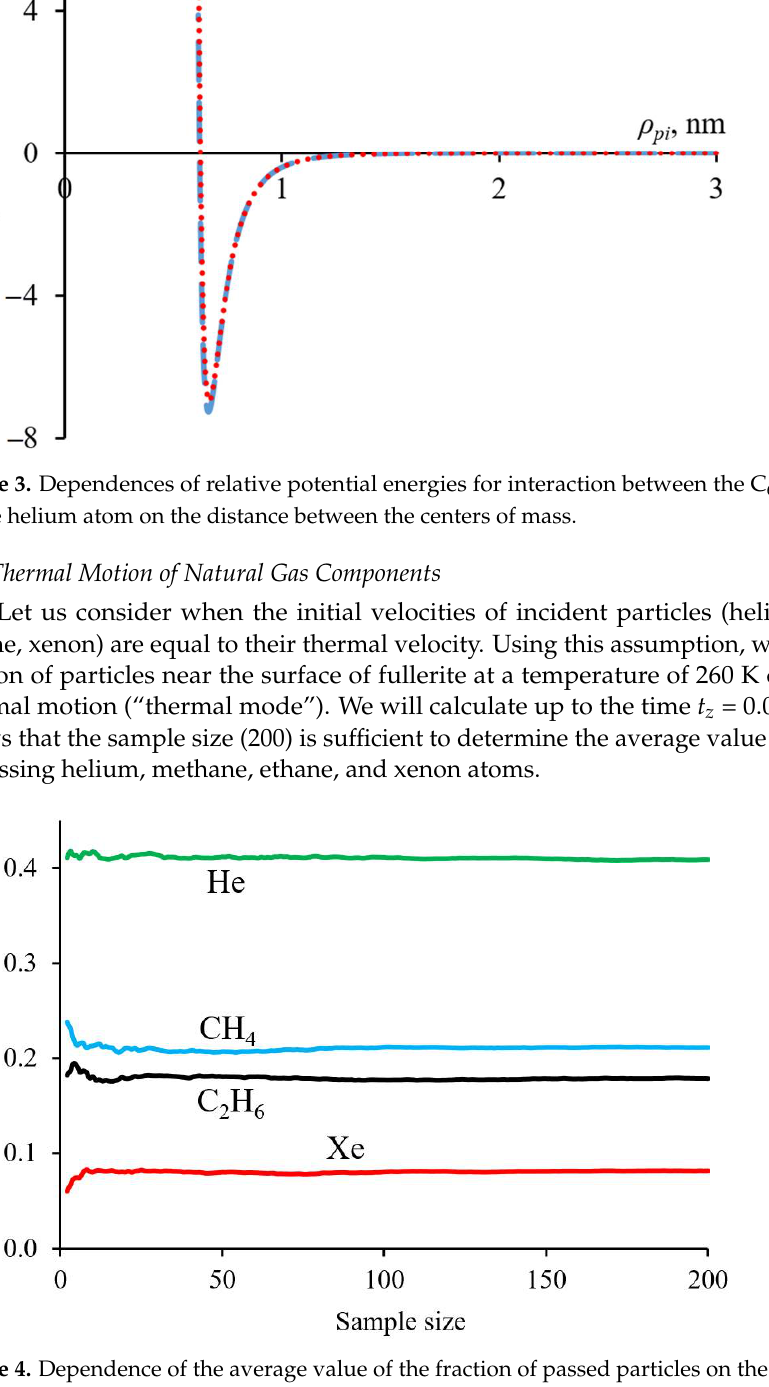
Figure 4. Dependence of the average value of the fraction of passed particles on the sample size.